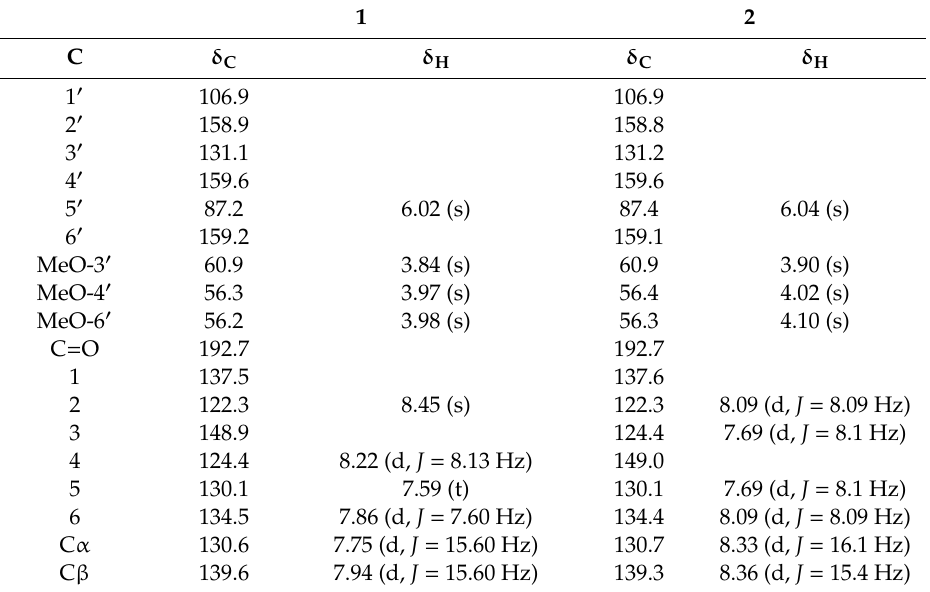
Table 1. 1 H and 13 C NMR data from chalcones 1 and 2 in CDCl 3 . The chemical displacements in 13 C and 1 H are in